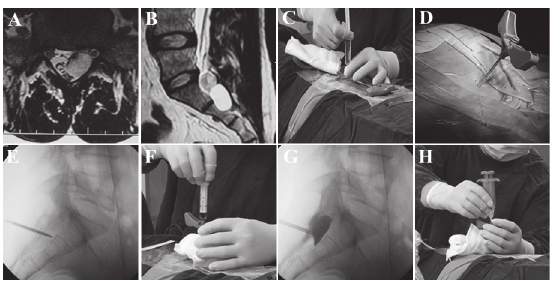
Fig 1. Procedure of fibrin gel therapy under C arm fluoroscopy machine guidance for symptomatic sacral perineural cysts. A and B. Transverse and sagittal T2WI MRI (prior to admission) show the location of cysts. C. Local anesthesia is induced with 2% lidocaine from skin to periosteum of sacral canal after needle insertion point is confirmed. D and E. Bone-puncture needle is used to puncture the sacral lamina and is inserted into the middle of the cyst guided by the C arm x-ray machine. F and G. CSF is aspirated and iohexol is injected to confirm the location of the bone-puncture needle in the cyst. H. Fibrin gel is injected into the